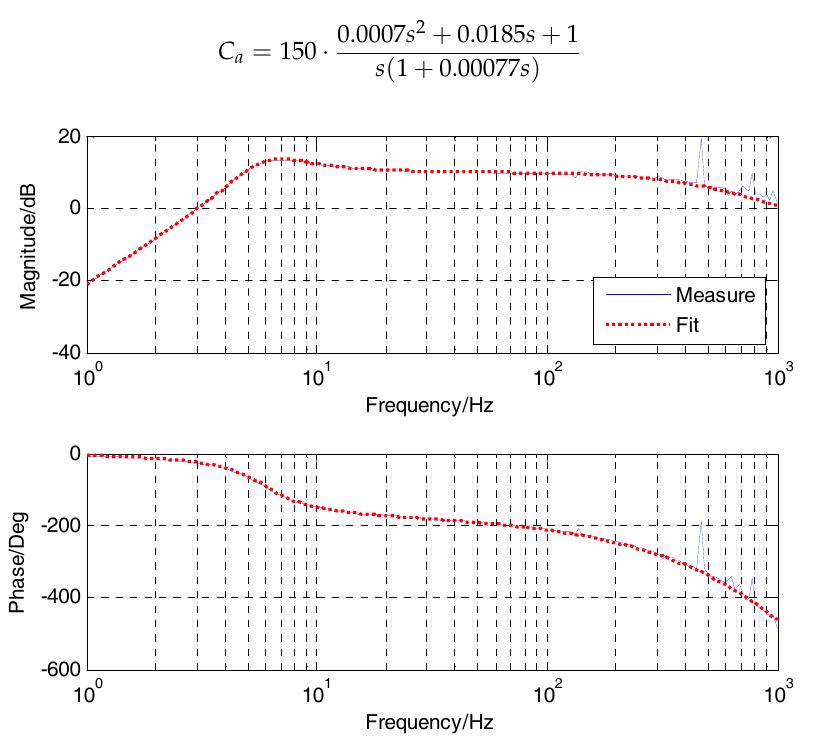
Figure 8. The acceleration open-loop bode response.